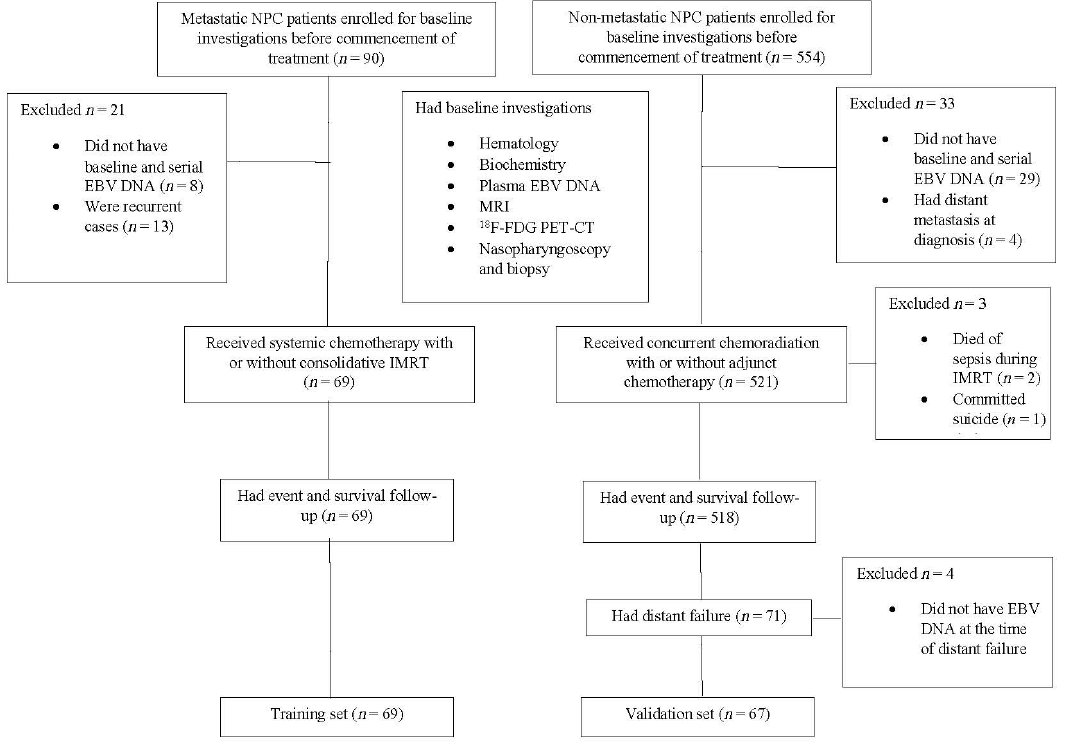
Figure 1. Study flowchart. NPC, nasopharyngeal carcinoma; EBV DNA, Epstein–Barr virus deoxyribonucleic acid; IMRT, intensity modulated radiation therapy; MRI, magnetic resonance imaging; 18 F-FDG PET-CT, 18-Fluorodeoxyglucose positron emission